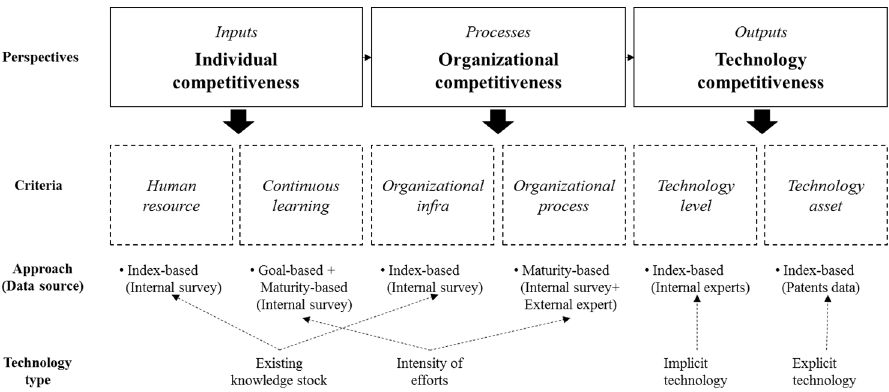
Figure 1. Technological capability evaluation model.